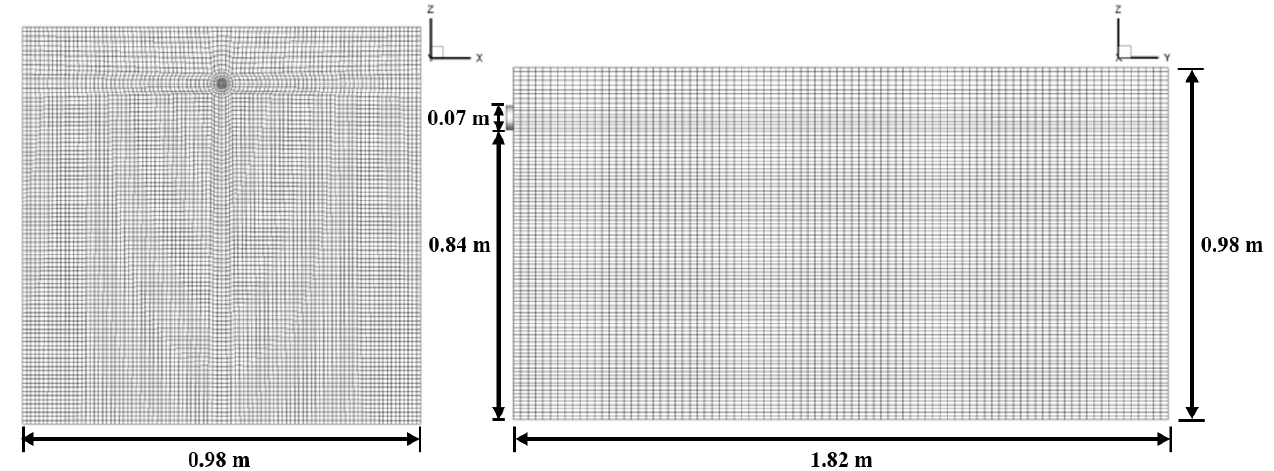
Figure 4. The left view—( a ) and front view—( b ) of the computational domain and mesh structure of Grid-2 (456,000